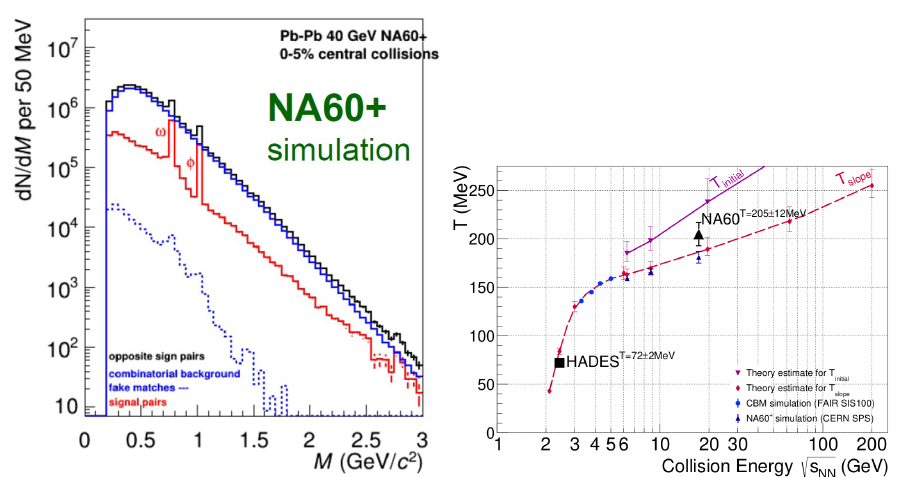
Figure 3. Left: simulated dimuon mass spectrum in central Pb-Pb collisions at E = 40 GeV per nucleon. Right: medium temperature evolution vs √ s NN in central Pb-Pb collisions using [2]. Mea- Figure 2. Layout of the proposed NA60 + apparatus in the low energy setup. surements from NA60 [4] and HADES